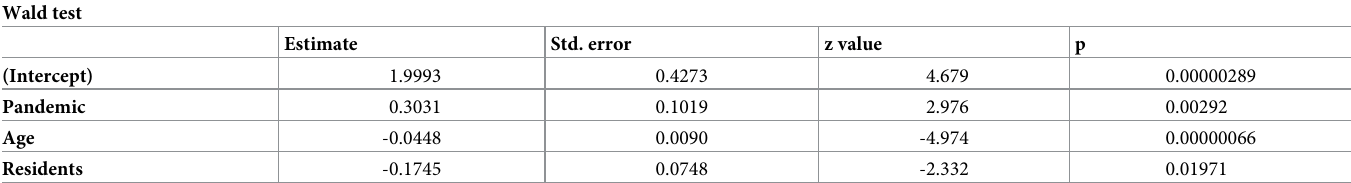
Table 2. The Wald test for the coefficients embodying the mixed logistic regression model to account for the effect of the pandemic on lucid dreams while control- ling for age and number of residents. Wald test Estimate Std. error